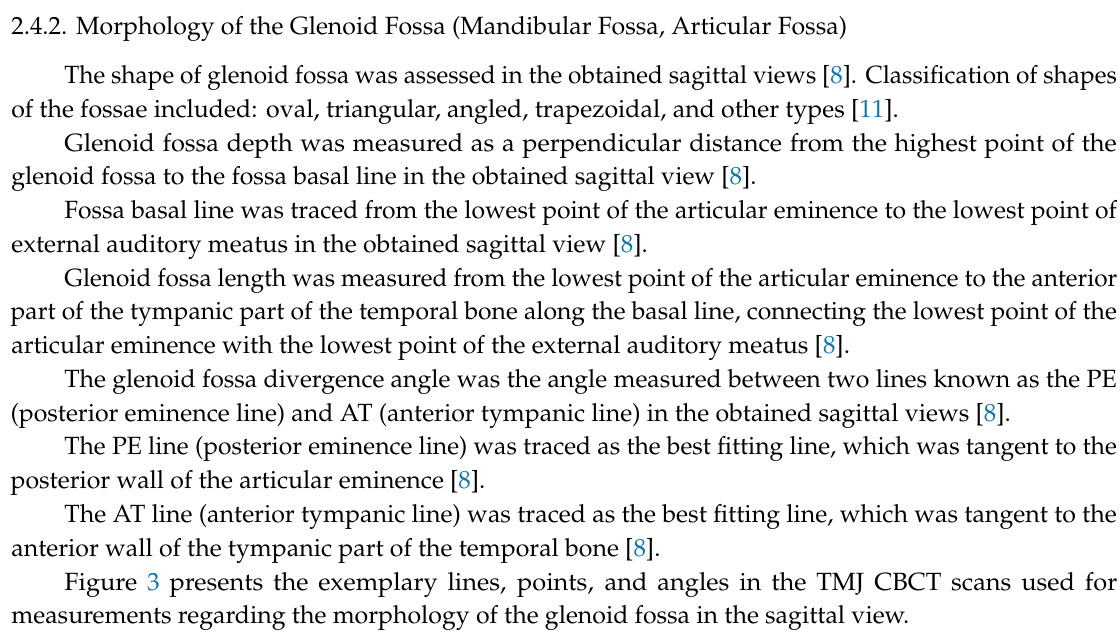
Figure 2. The exemplary lines, points, and angles in the TMJ CBCT scans used for measurements regarding the morphology of the mandibular condyle. ( a ) Morphology of mandibular condyle in the axial view: / a / condylar A-P dimension, / b / condylar width. ( b ) Shape of condyle head in the coronal view: condyle’s superior surface view assessment.